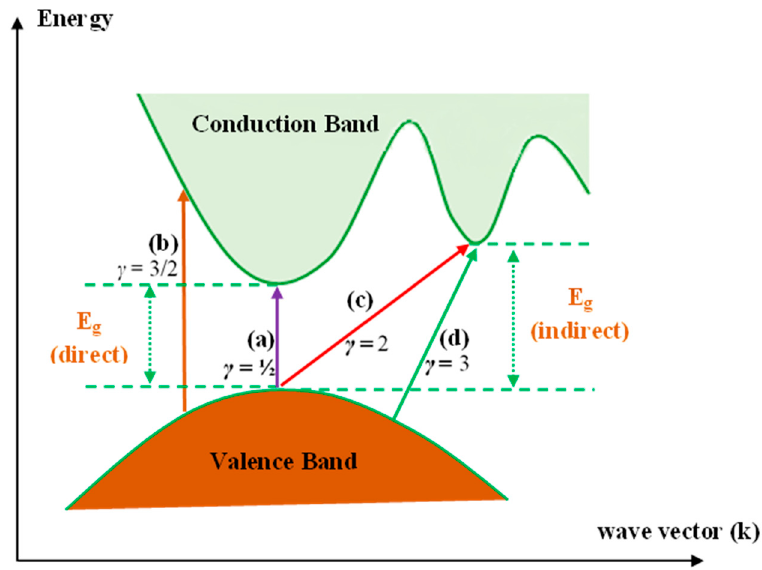
Figure 9. Transition types: (a)—direct allowed, (b)—direct forbidden, (c)—indirect allowed, and (d)—indirect forbidden [75].